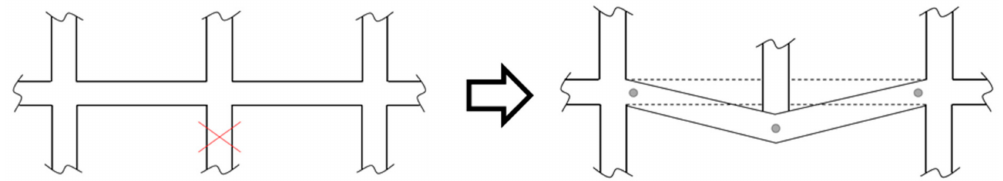
Figure 1. Idealized column removal